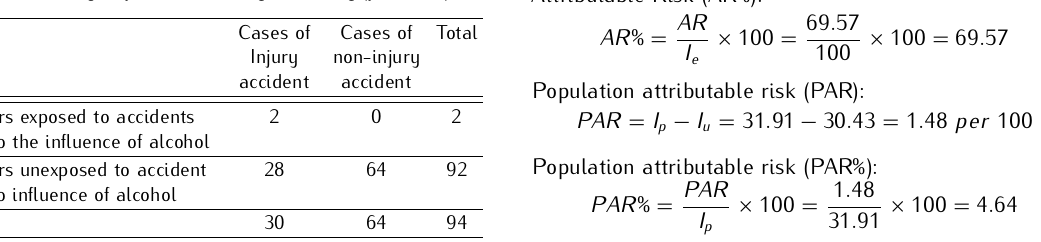
Table 5. Contingency table for drinking and driving (year